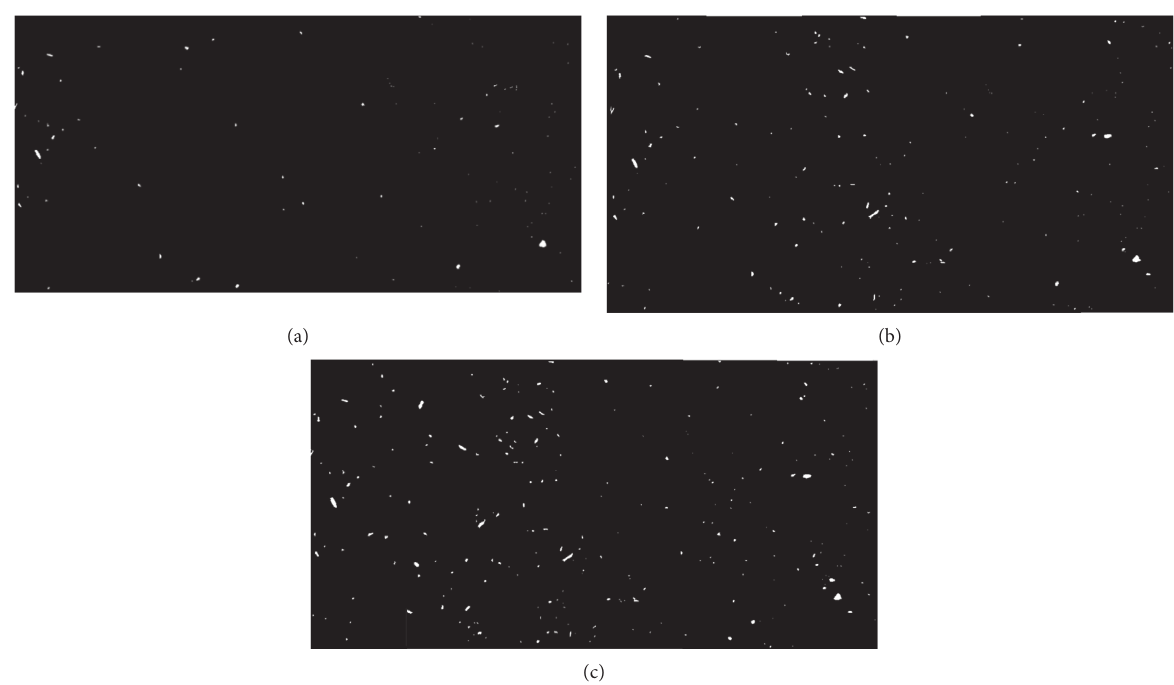
Figure 7: Fragment distribution on the left witness board: (a) target hitting picture (left) on witness board #1, (b) target hitting picture (left) on witness board #2, and (c) target hitting picture (left) on witness board #3.